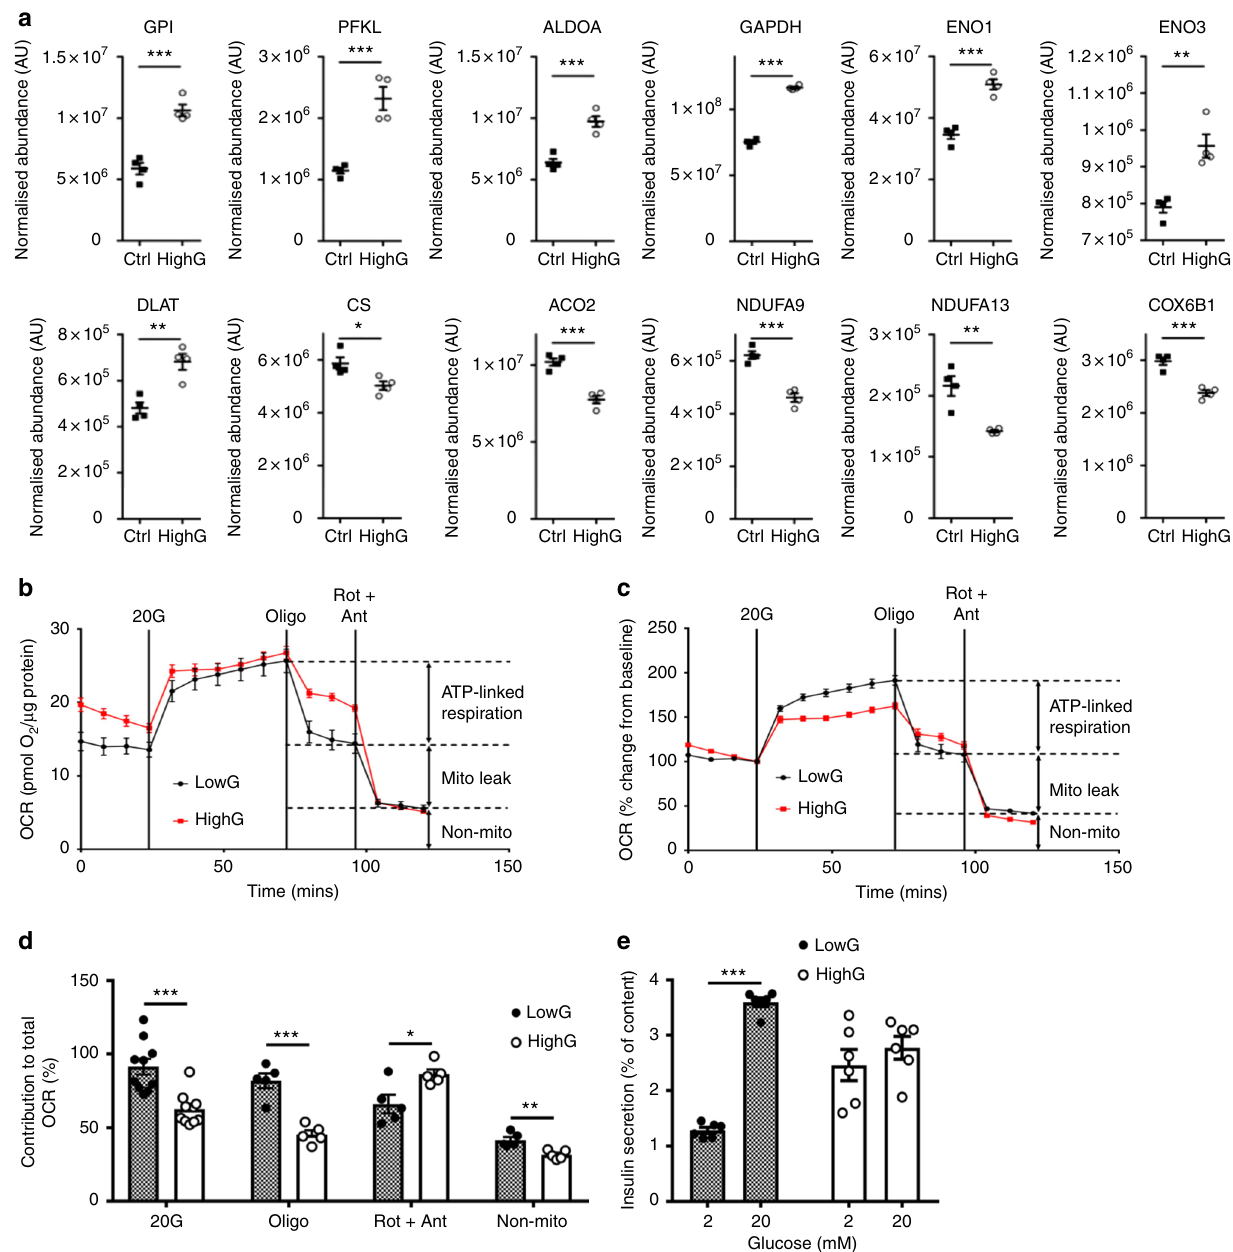
Fig. 7 Hyperglycaemia alters oxidative metabolism in INS-1 832/13 cells. a Abundance of the indicated proteins, quanti fi ed by mass spectrometry, in INS-1 cells cultured at 5 mM (black, Ctrl) or 25 mM (white, highG) glucose. Mean ± s.e.m. ( n = 4 replicates) and individual data points are indicated. * p < 0.05, ** p < 0.01, *** p < 0.001. Student ’ s t test (unpaired, two-sided). Above, enzymes involved in glycolysis. GPI, glucose 6-phosphate isomerase. PFKL, 6-phosphofructokinase, liver type. ALDOA, aldolase A. GAPDH, Glyceraldehyde 3-phosphate dehydrogenase. ENO1, enolase 1. ENO3, enolase 3. Below, mitochondrial enzymes. DLAT, dihydrolipoyllysine-residue acetyltransferase (a component of the pyruvate dehydrogenase complex). CS, citrate synthase. ACO2, aconitase 2. NDUFA9 and NDUF13, subunits 9 and 13 of NADH dehydrogenase:ubiquinone oxidoreductase (Complex 1). COX6B1, Cytochrome c oxidase subunit 6B1. b , c Oxygen consumption rate (OCR) in INS-1 cells cultured for 48 h at 5 mM (black) or 25 mM (red) glucose, expressed as absolute values ( b ) and as the percentage of change from the OCR baseline in 2 mM glucose ( c ). Data are mean ± s.e.m., n = 10 replicates/group (2 and 20 mM Glucose); n = 5, other compounds. d Percentage of change in OCR when glucose was raised from 2 to 20 mM (20G, n = 10 replicates/group), ATP-linked OCR (oligo, n = 5 replicates/group), OCR required to maintain the mitochondrial leak (rot + ant, n = 5 replicates/group) and non-mitochondrial OCR (non-mito, n = 5 replicates/group) in INS-1 832/13 cells cultured for 48 h at 5 mM glucose (hatched, lowG) or 25 mM glucose (white, highG). 20 G, 20 mM glucose. Oligo, 5 µ M oligomycine. Rot + Ant, 50 µ M rotenone + 5 µ M antimycin A. Mean ± s.e.m. Student ’ s t test (unpaired, two-sided). * p < 0.05; ** p < 0.01; *** p < 0.001. e Insulin secretion, expressed as a percentage of insulin content, for INS-1 cells cultured for 48 h at 5 mM (lowG, hatched) or 25 mM (highG, white) glucose and then exposed to 2 or 20 mM glucose. Mean ± s.e.m. ( n = 6 experiments). Two-way analysis of variance ** p <